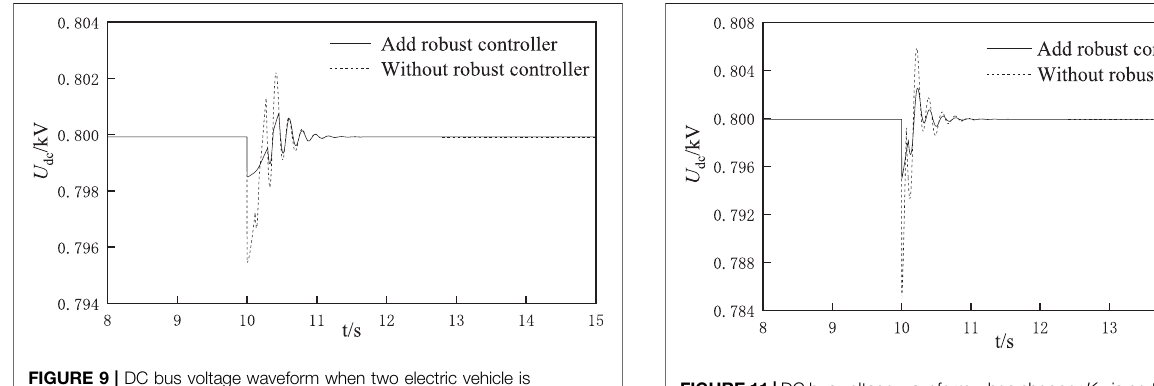
FIGURE 11 | DC bus voltage waveform when chopper K ip is perturbed.